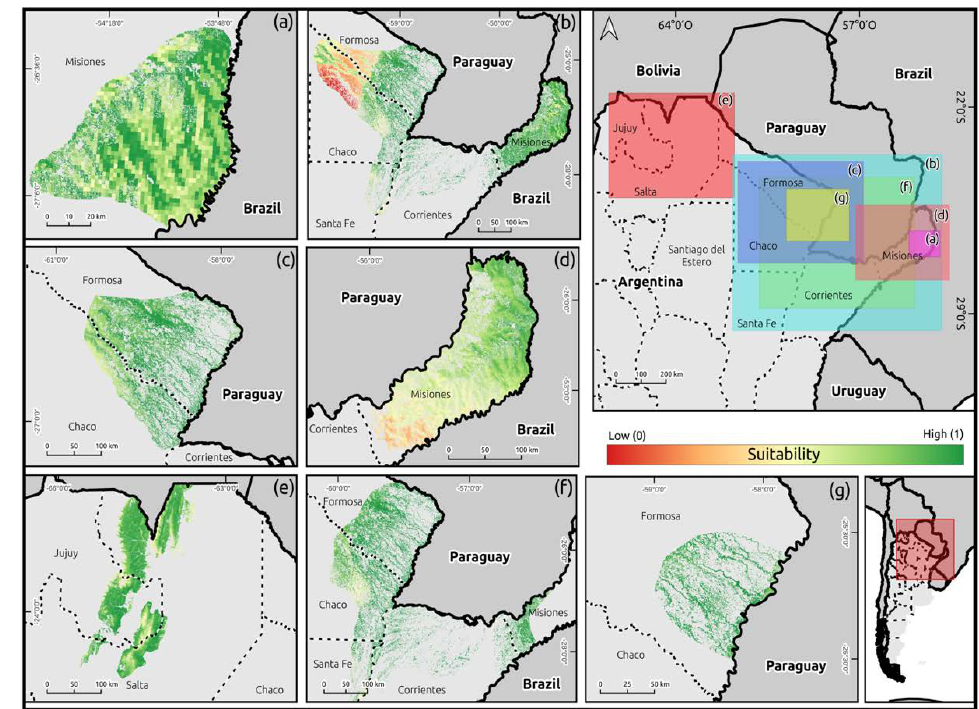
Figure 1. Species suitability pattern for the five primate species native to Argentina: ( a ) brown howler monkey ( Alouatta guariba ), ( b ) black-and-gold howler monkey ( Alouatta caraya ), ( c ) Azara’s owl monkey ( Aotus azarae ), ( d ) black-horned capuchin monkey ( Sapajus nigritus ), and ( e ) Azara’s capuchin monkey ( Sapajus cay ). The additional polygons delimiting areas of high population density for ( f ) A. caraya and ( g ) A. azarae are reported.